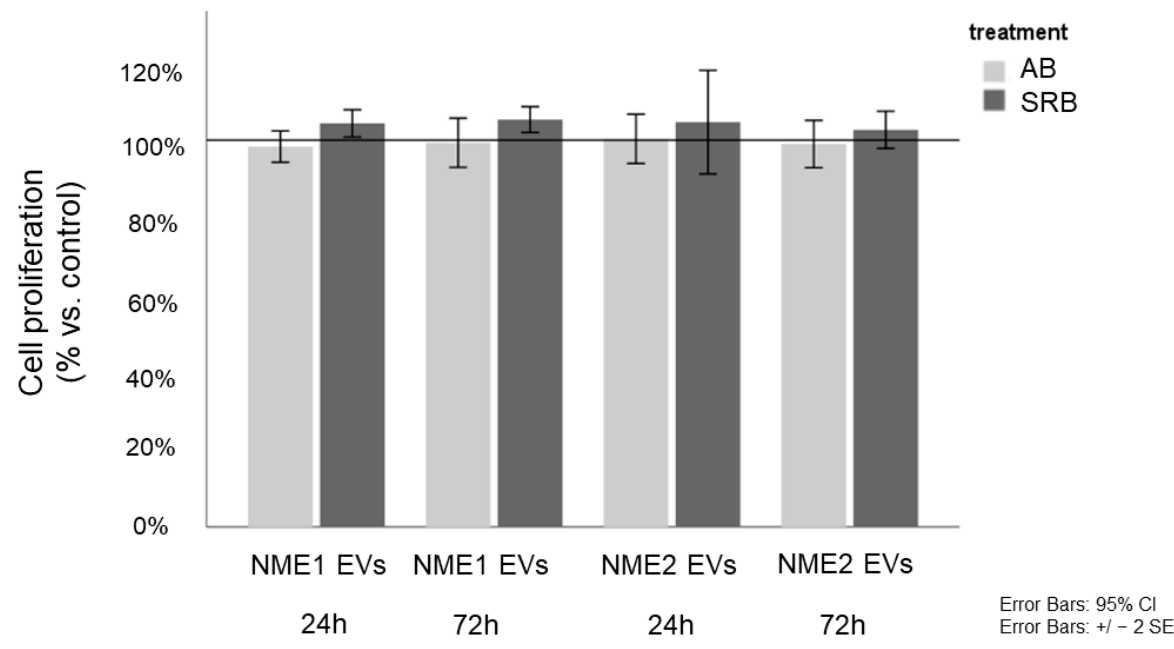
Figure 6. NME1-EV or NME2-EV treatment does not influence proliferation of fibroblasts. Alamar blue (AB) and sulforhodamine B (SRB) assays monitored the in vitro cell growth of EV-treated fibroblasts after 24 and 72 h. Cell proliferation of NME1-EV and NME2-EV treated fibroblasts is given in % of control (mean ± SD). Control corresponds to Co-EV treated fibroblasts. All data represent mean ±